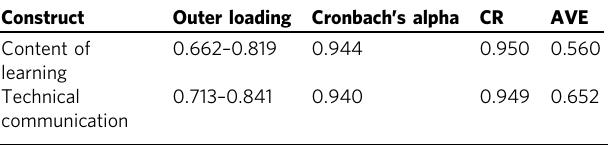
Table 10 Assessment of the